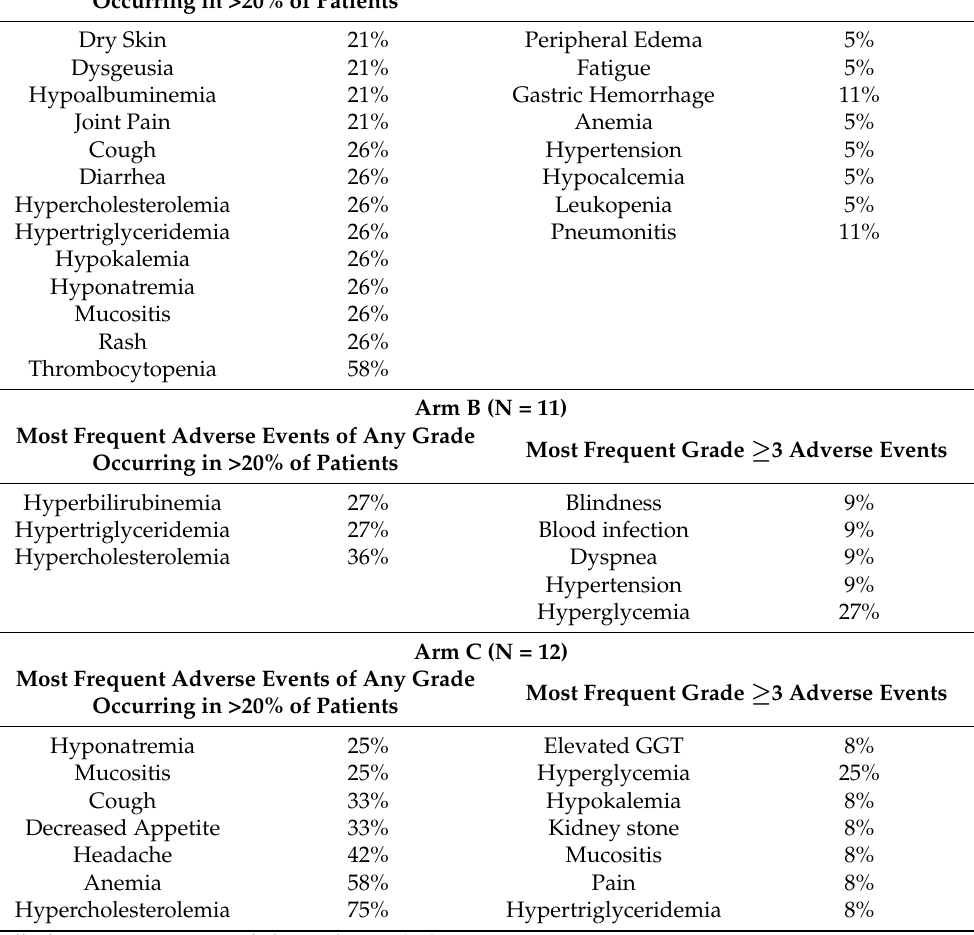
Table 2. Treatment emergent adverse events by treatment arm showing the most common toxicities and the highest-grade